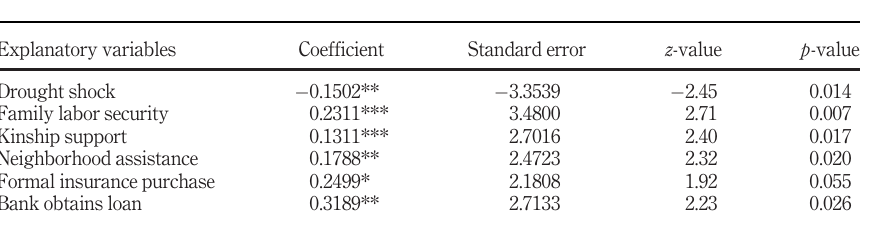
Table 6. Marginal effect